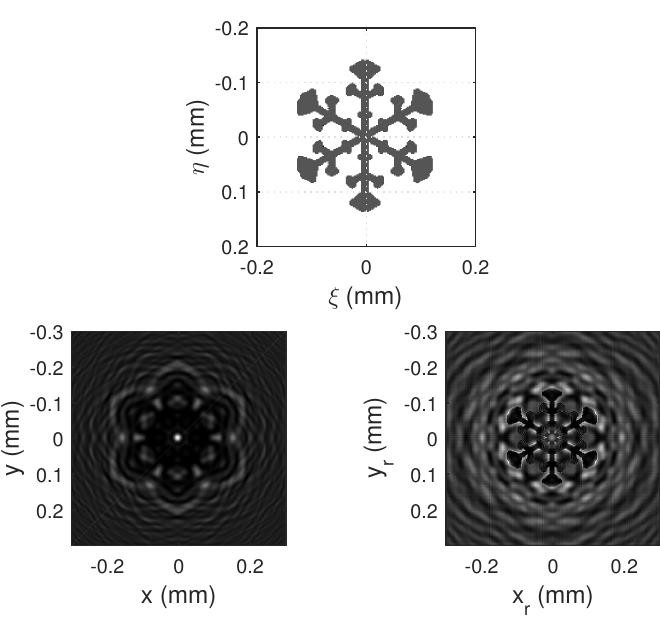
Figure 10. Transparent phase particle whose form is the one of a dendritic crystal with sector-like ends ( top ); Example of Digital In-line Hologram generated by this particle ( bottom left ) and its optimal reconstruction using 2D-FRFT ( bottom right